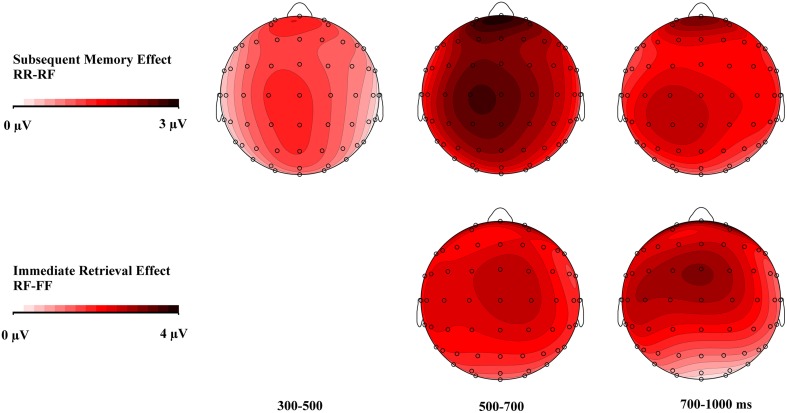
Topographical maps showing the scalp distributions of the subsequent memory effect (RR-RF) and the immediate retrieval effect (RF-FF). The subsequent memory effect started at an earlier time window (300–500 ms). Both effects show similar scalp topography in the 500–700 ms time window. The voltage scale is from 0 to 3 μV for the subsequent memory condition and from 0 to 4 μV for the immediate retrieval condition.